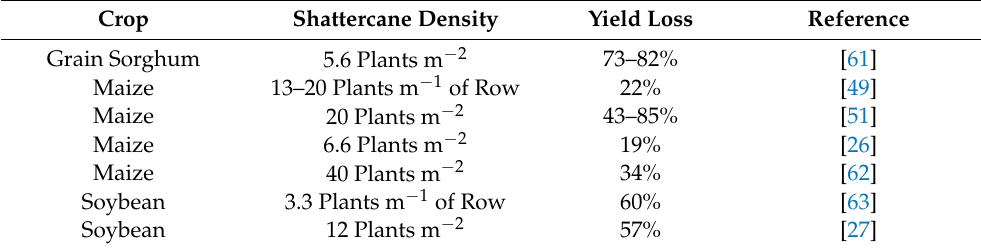
Table 1. Yield losses of summer field crops due to shattercane ( Sorghum bicolor (L.) Moench